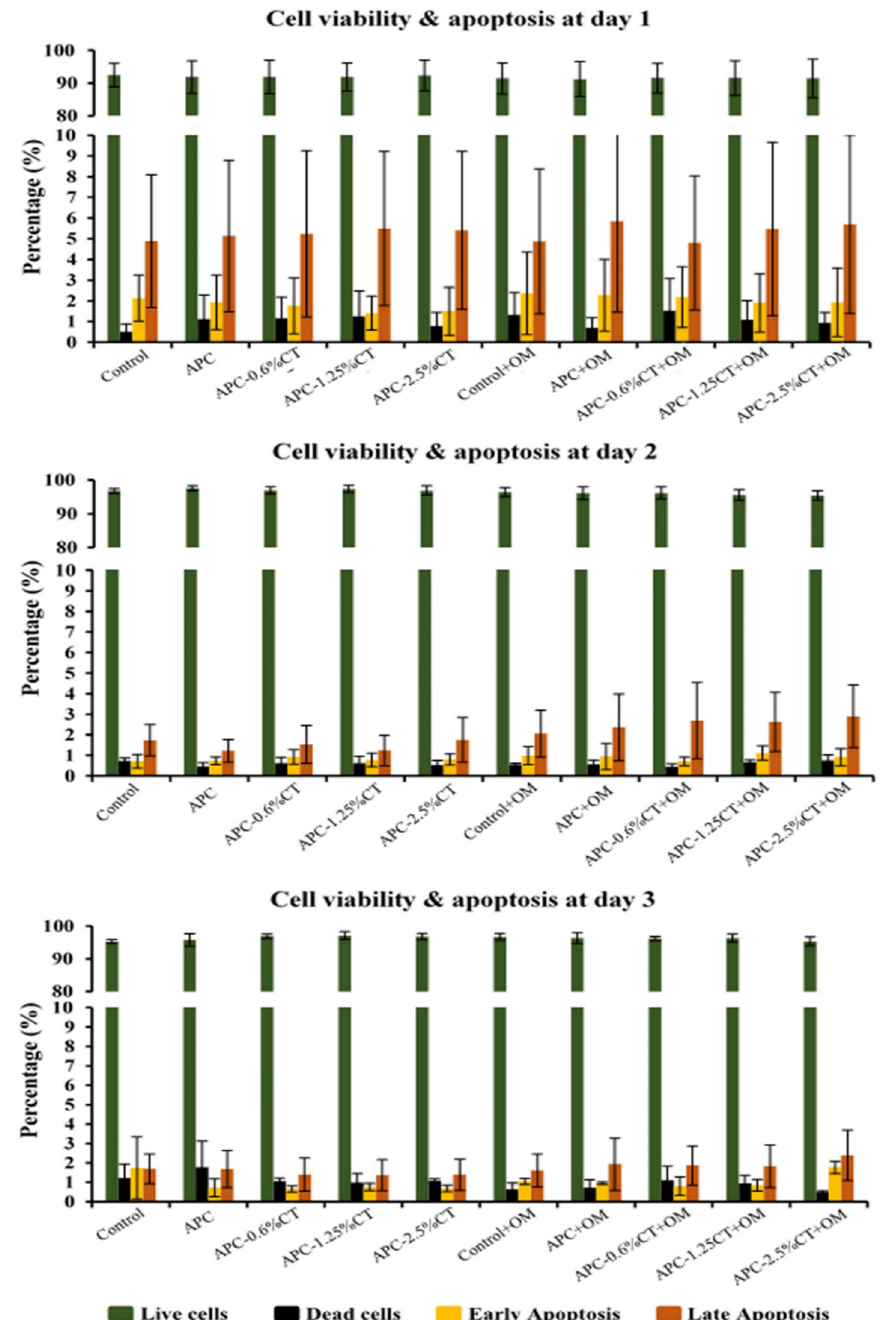
Figure 2. Cytotoxicity induced by APC and APC-CT on SHED using flow cytometry. The graphs present cell population as viable, early apoptotic and late apoptotic cells after 1, 2 and 3 days. Data represent the mean ± SD of three independent experiments ( n = 3). Statistical analysis indicated no significant difference among the groups at any time point.